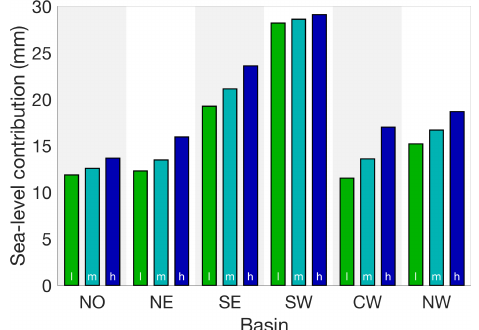
Figure 9. Regional analysis of uncertainty due to ocean forcing. Ensemble mean sea-level contribution for MIROC5-RCP8.5 for low (green), medium (cyan) and high (blue) ocean forcing. The mean of the total Greenland contribution is 97, 101 and 116mm for low, medium and high ocean forcing,